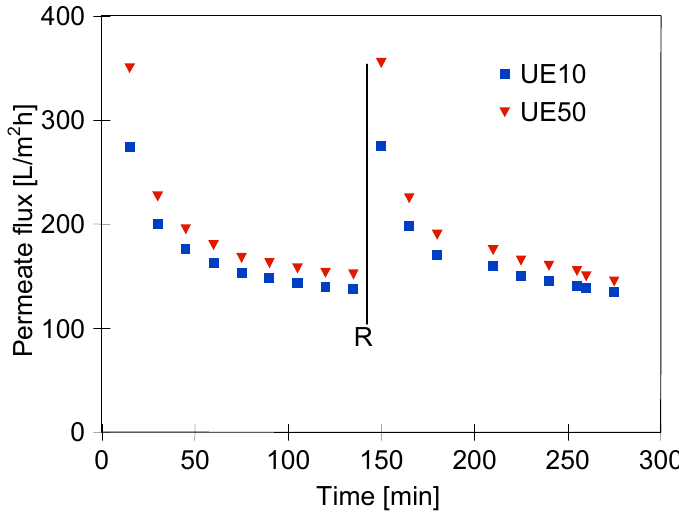
Figure 14. Changes in the permeate flux during the UF process of real wastewaters. Feed: the solution collected during car washing with 0.5% solution of the white cleaning agent. TMP = 0.2 MPa, feed flow velocity: 1 m/s. R-rinsing using 1 g/L NaOH.